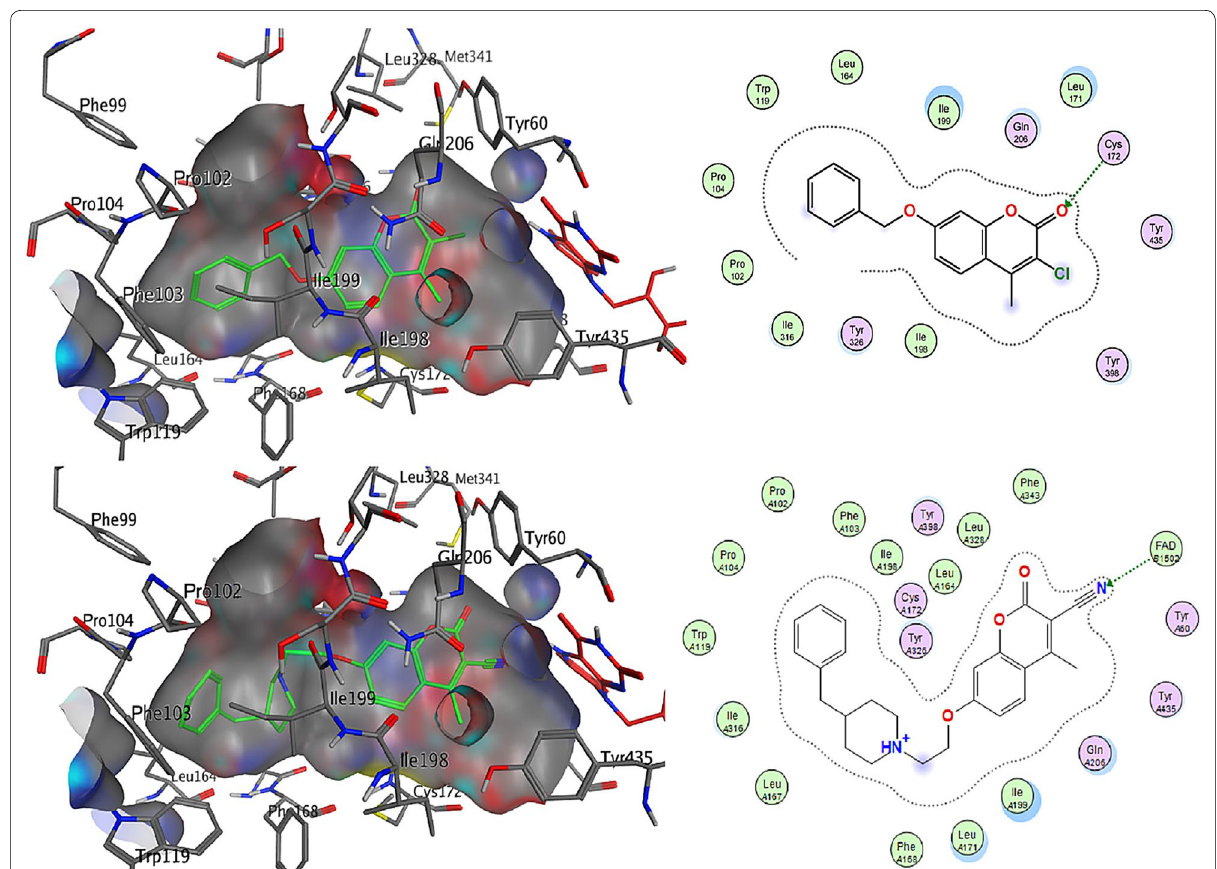
Fig. 88 The hMAO-B active site cavity (left) and interaction maps (right) displaying the binding and interactions of compounds C96b (top) and C96c (bottom)